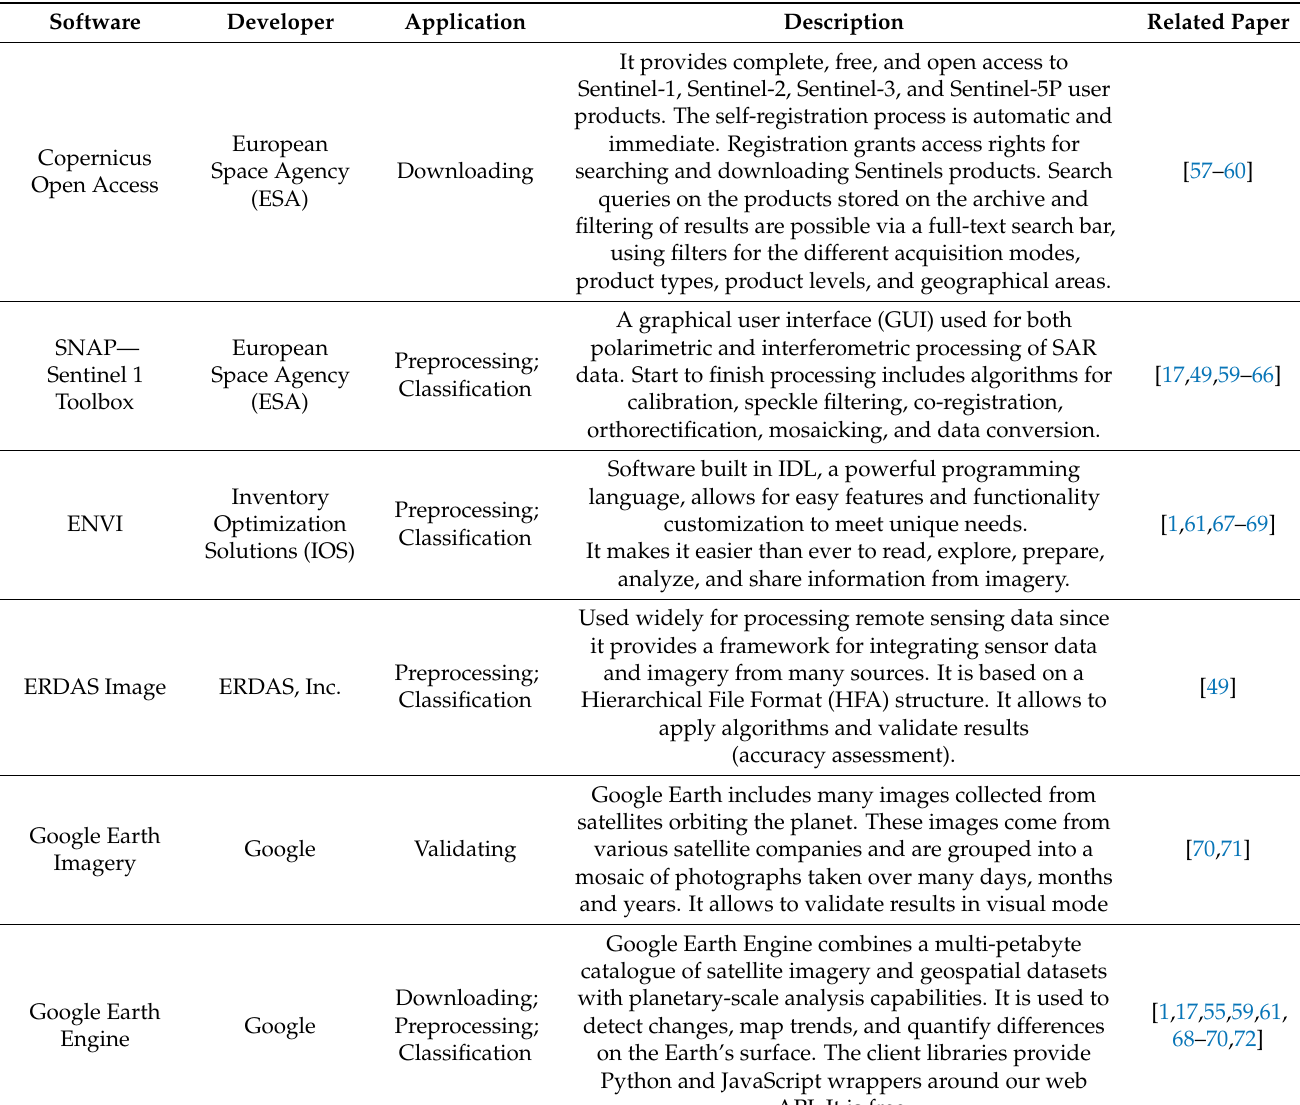
Table 2. Characteristics of common Software used for Sentinel-1 pre-processing and